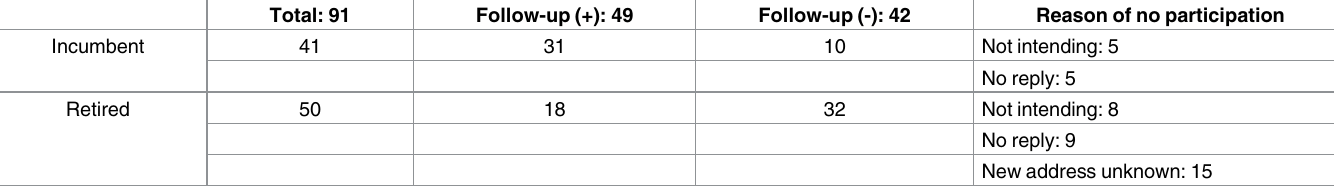
Table 1. Details of the participants of the follow-up study.